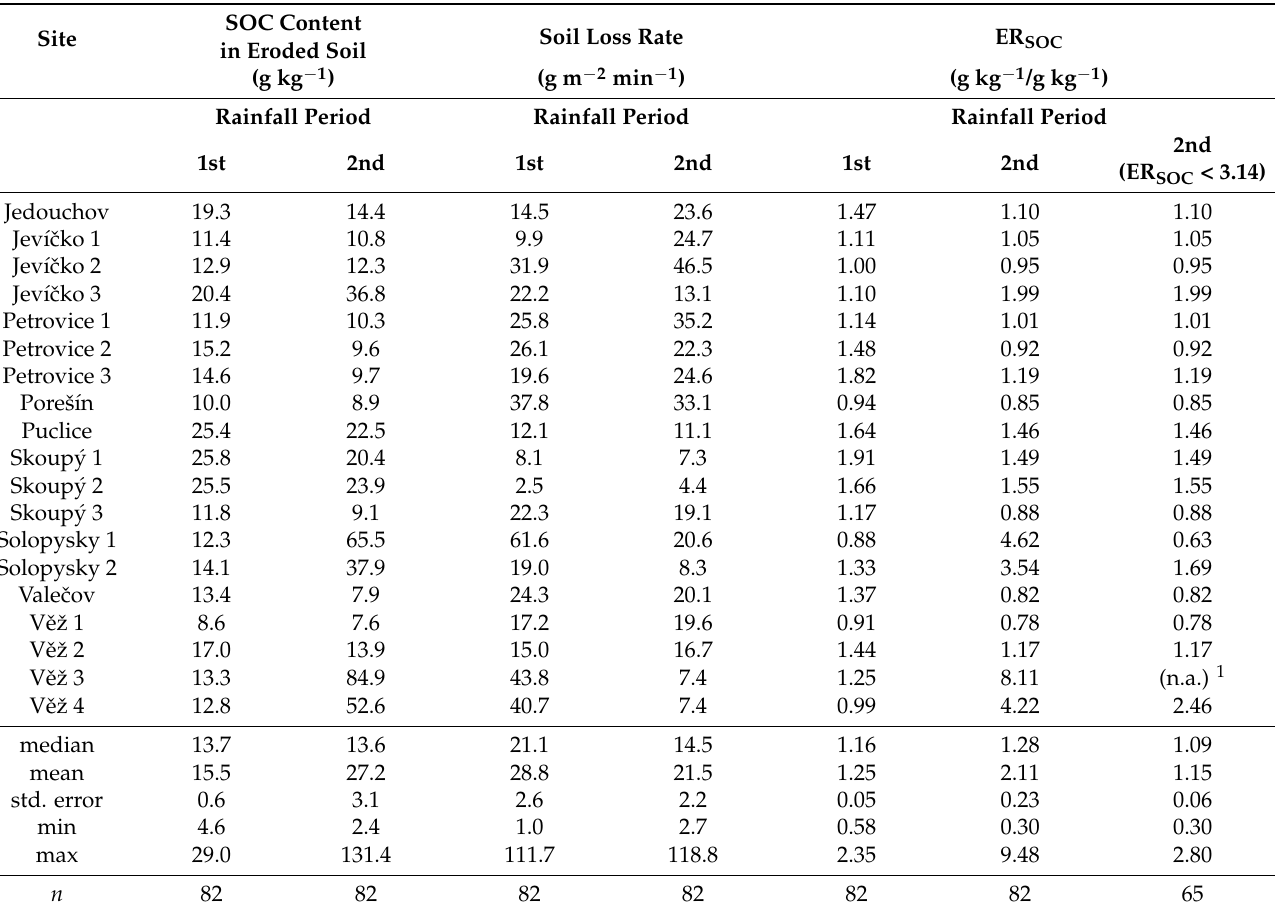
Table 2. Mean values for each site and summary statistics across all of the sites for the soil organic carbon (SOC) content in the eroded soil, for the soil loss rate, and for the soil organic carbon enrichment ratio (ER SOC ), determined in 82 rainfall simulations. The first rainfall period (1st) lasted 30 min and the second rainfall period (2nd) lasted 15 min. For ER SOC , the column ‘2nd (ER SOC < 3.14)’ contains the mean values and summary statistics of ER SOC in the second rainfall period after removing the data of those 17 rainfall simulations, which resulted in a noticeably high SOC enrichment of ER SOC > 3.14 (see Sections 3.2 and